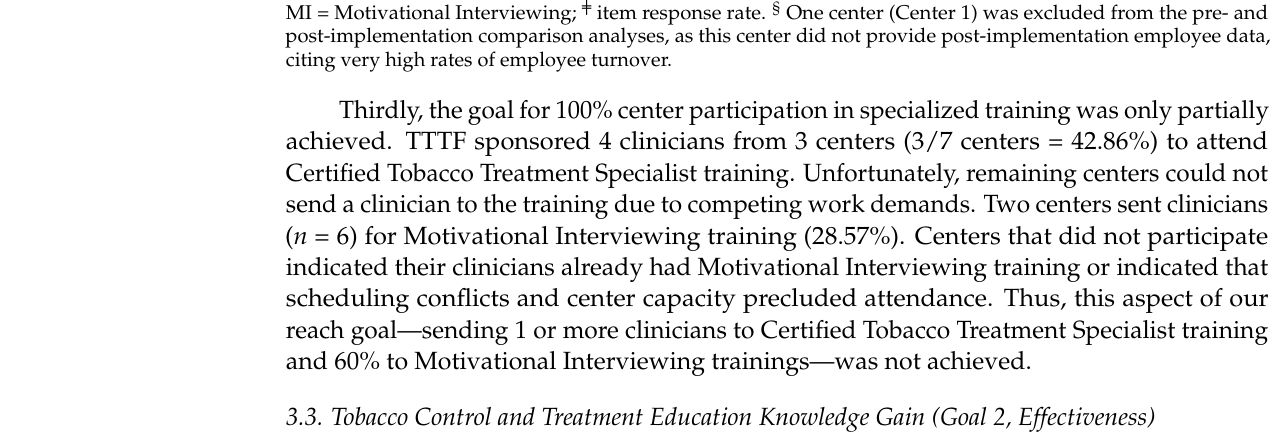
Table 2. Training receipt from pre- to post-implementation among responding employees and cli- nicians in opioid addiction treatment centers. The effects of tobacco smoke on psychiatric medications